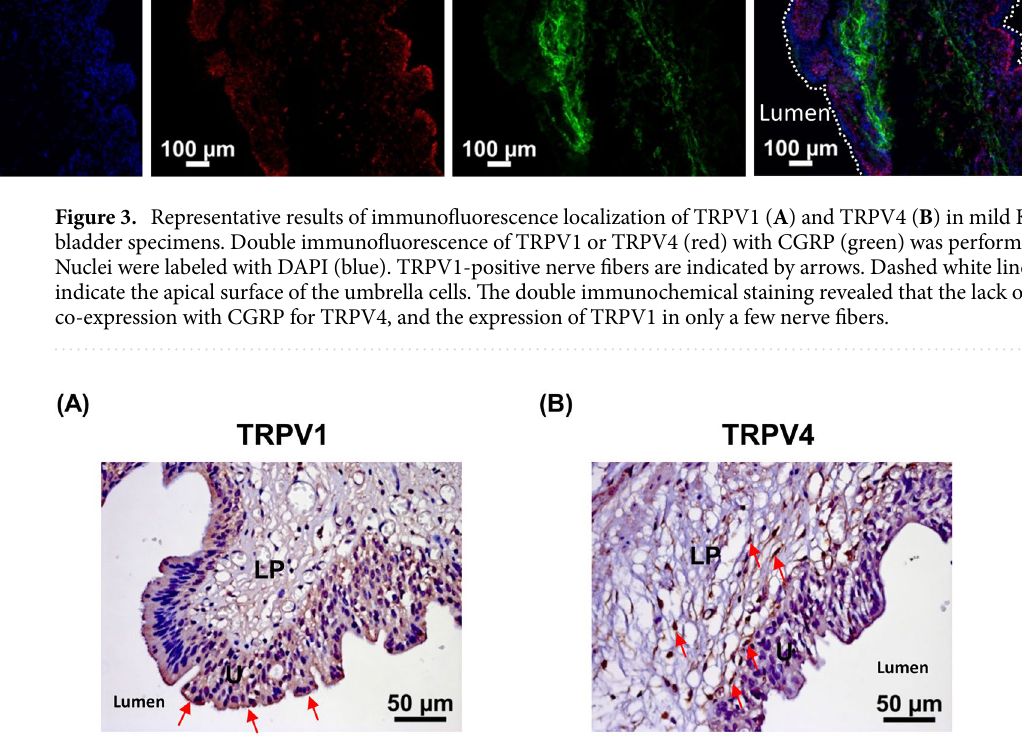
Figure 4. Representative results of IHC of TRPV1 ( A ) and TRPV4 ( B ) in severe KC bladder specimens. Arrows indicate TRPV1 or TRPV4 positive cells. The expression of TRPV1 is mainly distributed in all urothelial cell layers. In contrast, TRPV4 was found in the basal cells and lamina propria. U urothelium, LP lamina